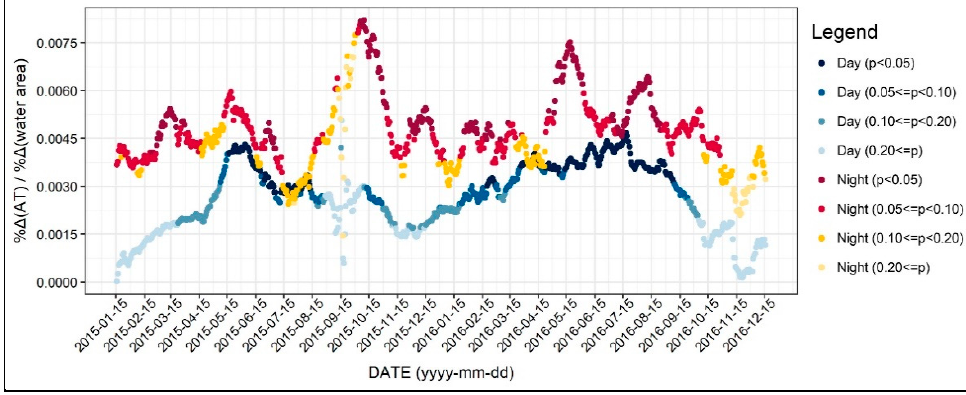
Figure 17. Changing patterns in the regression coefficients and their significances (water area).